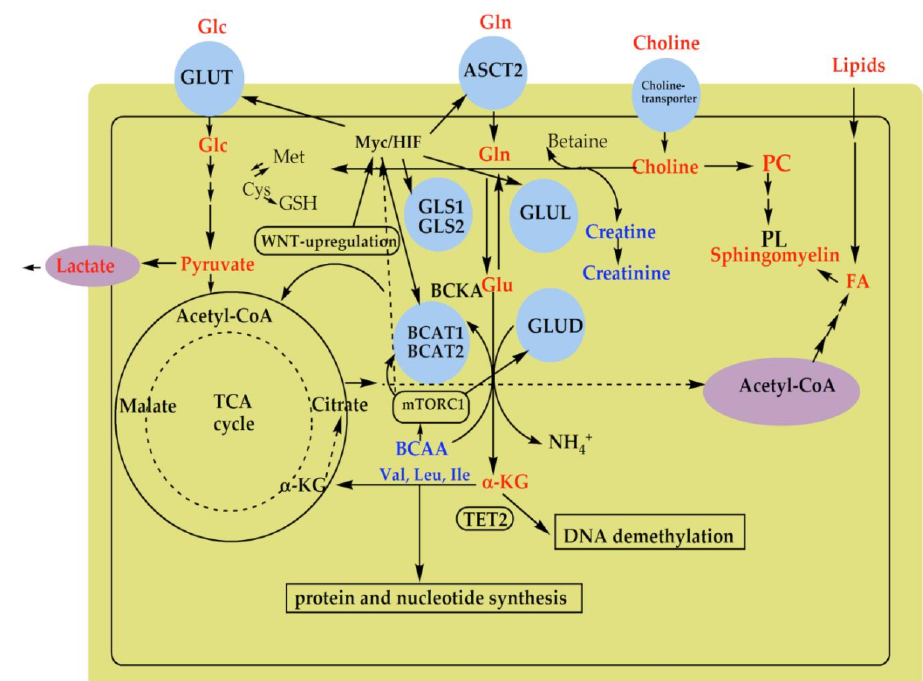
Figure 5. Illustration of the main metabolic pathways that are reported to be altered in WT. Metabo- lites with altered concentrations in WT tissues included glucose (Glc), glutamine (Gln), glutamate (Glu), α -ketoglutarate ( α -KG), phosphatidylcholine (PC), phospholipids (PL), branched-chain amino acids (BCAAs, such as valine (Val), leucine (Leu), isoleucine (Ile)), as well as, cysteine (Cys), methion- ine (Met), and glutathione (GSH). Metabolic pathways in WT are altered by oncogenes and tumor suppressor genes such as MYC , hypoxia-inducible factors ( HIF) , transforming growth factor-beta (TGF β )-WNT, and complex 1 of the mammalian target of rapamycin (mTORC1) signaling pathways promoting upregulation of many metabolic enzymes including glutaminase (GLS1 and GLS2), glu- tamine synthetase (GLUL), glutamate dehydrogenase (GLUD), branched-chain aminotransferase (BCAT1 and BCAT2), ten-eleven translocation 2 DNA demethylase (TET2), and transporters such as transporter of glucose (GLUT) and glutamine